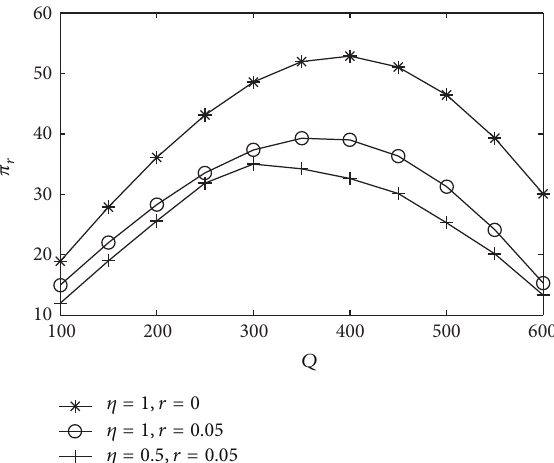
Figure 4: Impact of 𝜂 and 𝑟 on retailer’s profit.